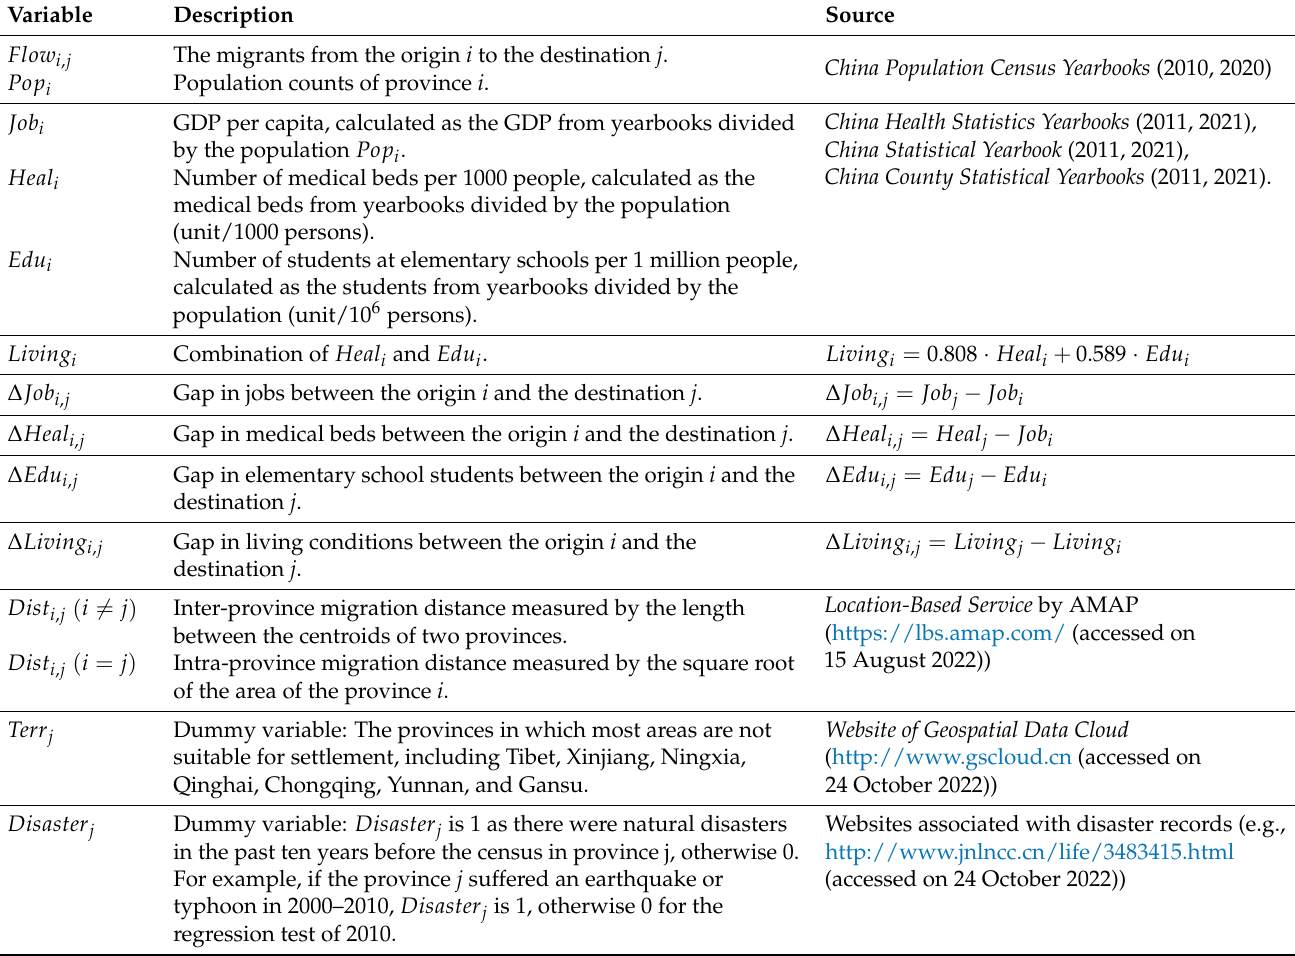
Table A1. Detailed description of data